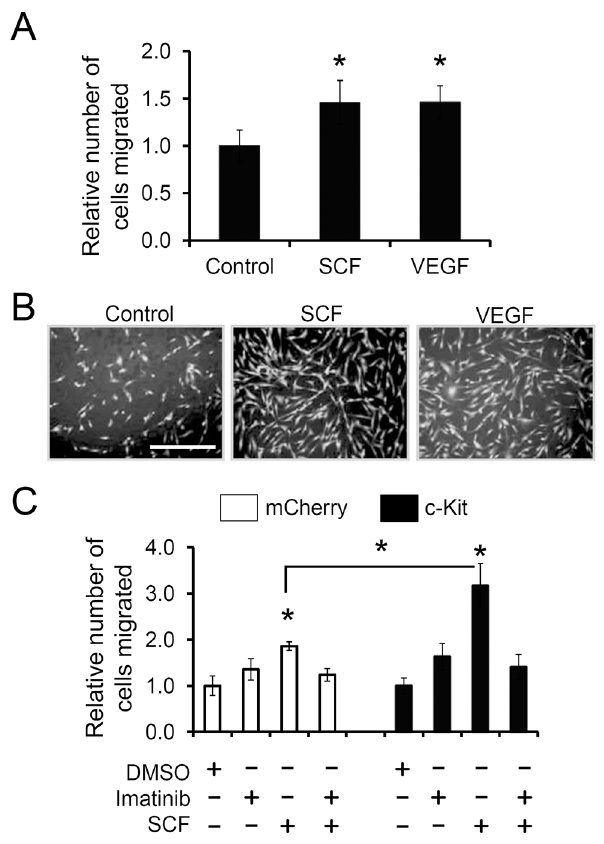
Fig 4. c-kit activation promotes migration of CPCs. Boyden chamber assay. Human c-kit+ CPCs were plated in the upper chamber, and the indicated growth factors were used as a chemoattractant in the lower chamber. After 24 hr, the migrated cells were fixed, stained with propidium iodide, and counted. A, Comparison of the pro-migratory effect of SCF and VEGF. B, Representative images showing the cells that migrated towards the indicated growth factors. C, CPCs transduced with lentivirus expressing mCherry (control) or c-kit were compared for their chemotaxis towards SCF in the presence (+) or absence (-) of 0.5 mM imatinib. Values presented are mean ± SEM. * , p <